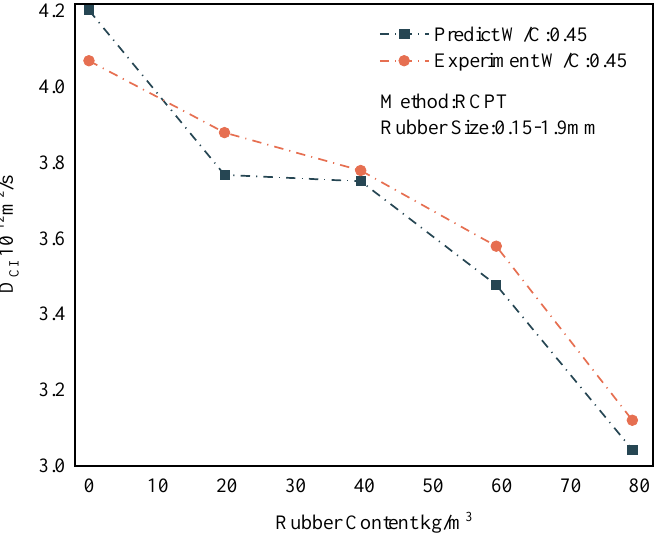
Figure 20. Prediction results of the MWOA-ELM model for the literature [22].